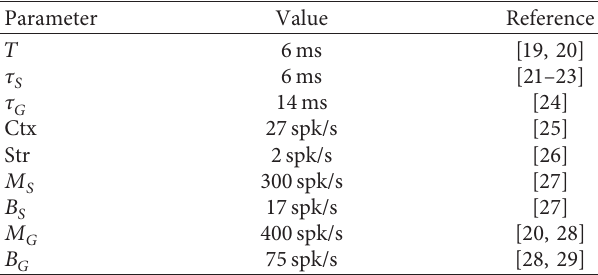
Figure 2: (a) Curves of the activation functions F Table 1: Parameter values in the model and their sources. Parameter Value Reference